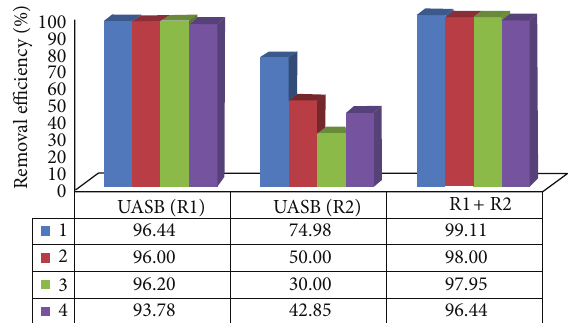
Figure 7: Average values of the removal efficiencies of Ascari ssuum eggs in UASB reactors (R1 and R2) and R1 + R2 of treatment system I in assays 1, 2, 3, and 4.